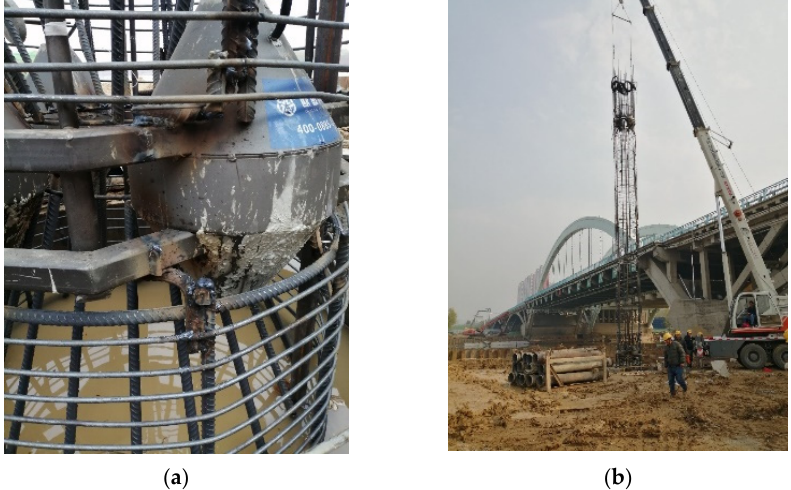
Figure 6. Installation of ( a ) supercell and ( b ) reinforcement cage.